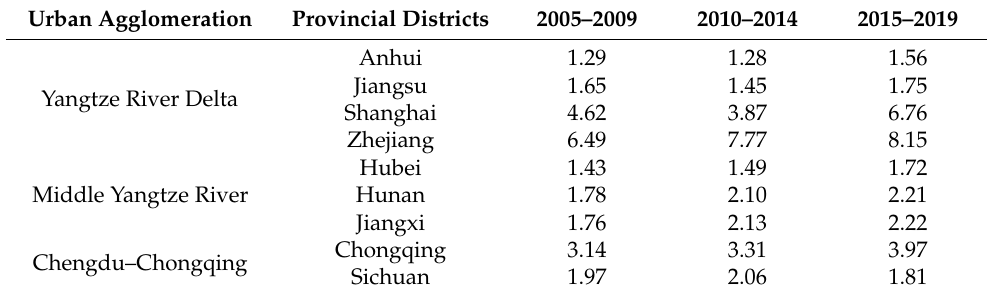
Table 1. Water resources equalization factors for nine provinces,